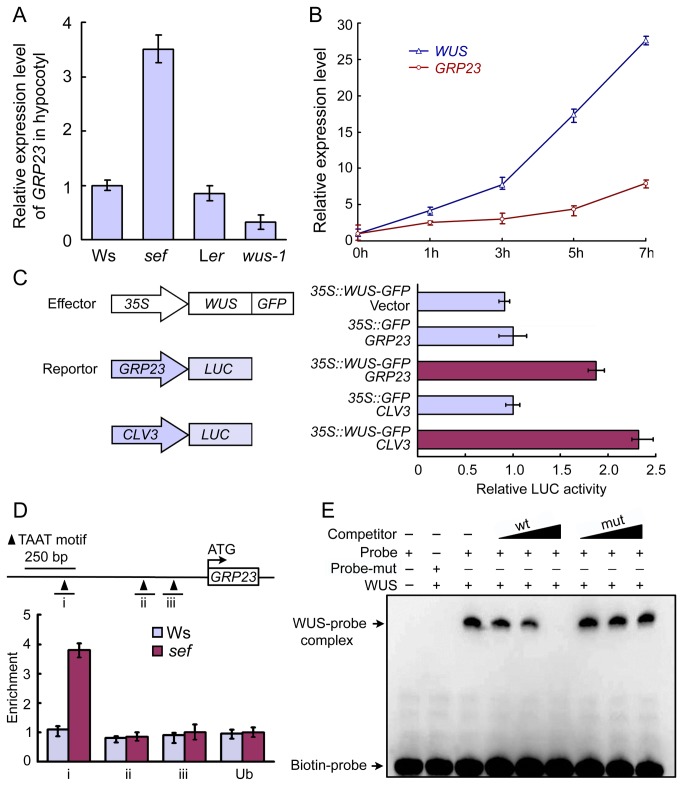
WUS binds the GRP23 promoter directly to activate its expression.(A) qRT-PCR analysis of GRP23 expression in Ws, sef, Ler and wus-1. Data are means ± SD (n = 3). (B) qRT-PCR analysis of GRP23 expression in 14-day-old pga6 seedlings after inducing with 17-β-estradiol for 1, 3, 5 and 7 hours. Data are means ± SD (n = 3). (C) Transient expression assay in
Arabidopsis
 protoplasts. The promoters of GRP23 and CLV3 were used to drive the luciferase (LUC) reporter gene. WUS:GFP fusion driven by the 35S promoter was used as effector. LUC activity was assayed after transformation. Data are means ± SD (n = 3). (D) ChIP assay of 7-day-old seedlings to show WUS-binding regions in GRP23 promoter. Regions i, -784 to -660; ii, -311 to -211; iii, -195 to -95. Data are means ± SD (n = 3). (E) EMSA of WUS binding the GRP23 promoter in
vitro. The unlabeled double-strands probe (wt) and unlabeled mutant probe (mut) were used for competitive inhibition with 200X, 400X, or 800X molar excess.